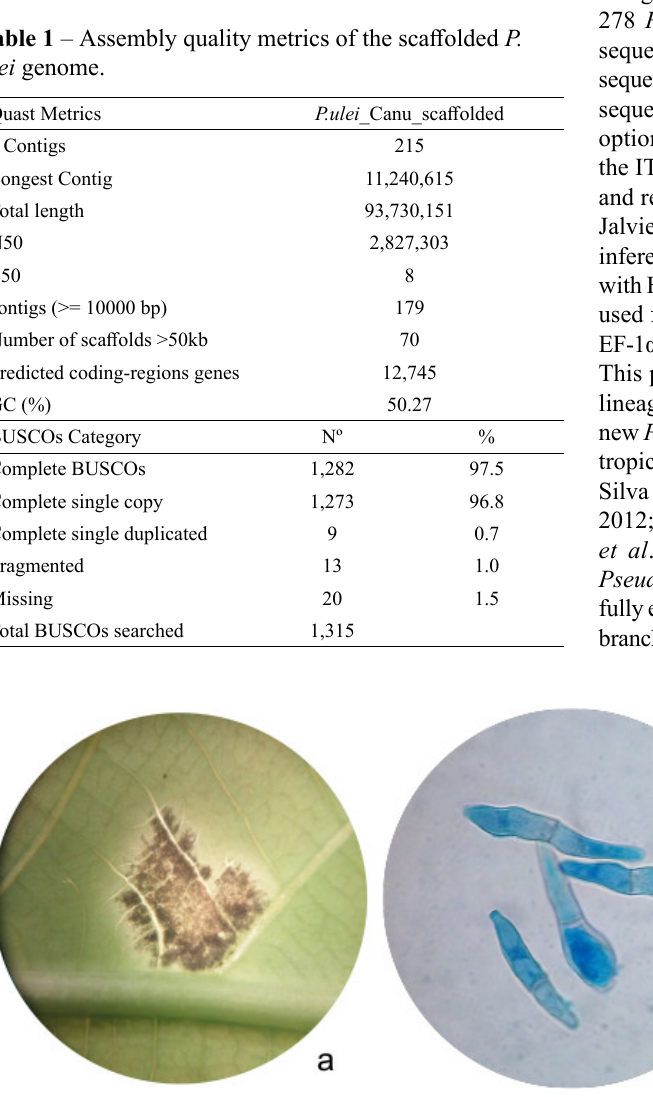
Figure 1 – P. ulei in vitro culture: isolation and stroma propagation. a. A single plant lesion, magnification 1x. b. P. ulei conidias stained with lactophenol blue solution, magnification 100x. c. Growth of stroma in an Erlenmeyer 125 ml with sporulation artificial media (M4) at 14 days. Photos from the Molecular Characterization Laboratory, Biotechnology Institute, National University of Colombia – Natural Rubber Research. Photos taken by Sandra Milena Gonzalez-Sayer (a and c) and Maria Elizabeth Mendez Tibambre (b). Photo a), taken with Advanced optical stereoscopy, serial:0709011, Photo b), taken with Olympus Microscopy CH30 model, serial: T39D15816. Photo c), taken with an iPhone 6s